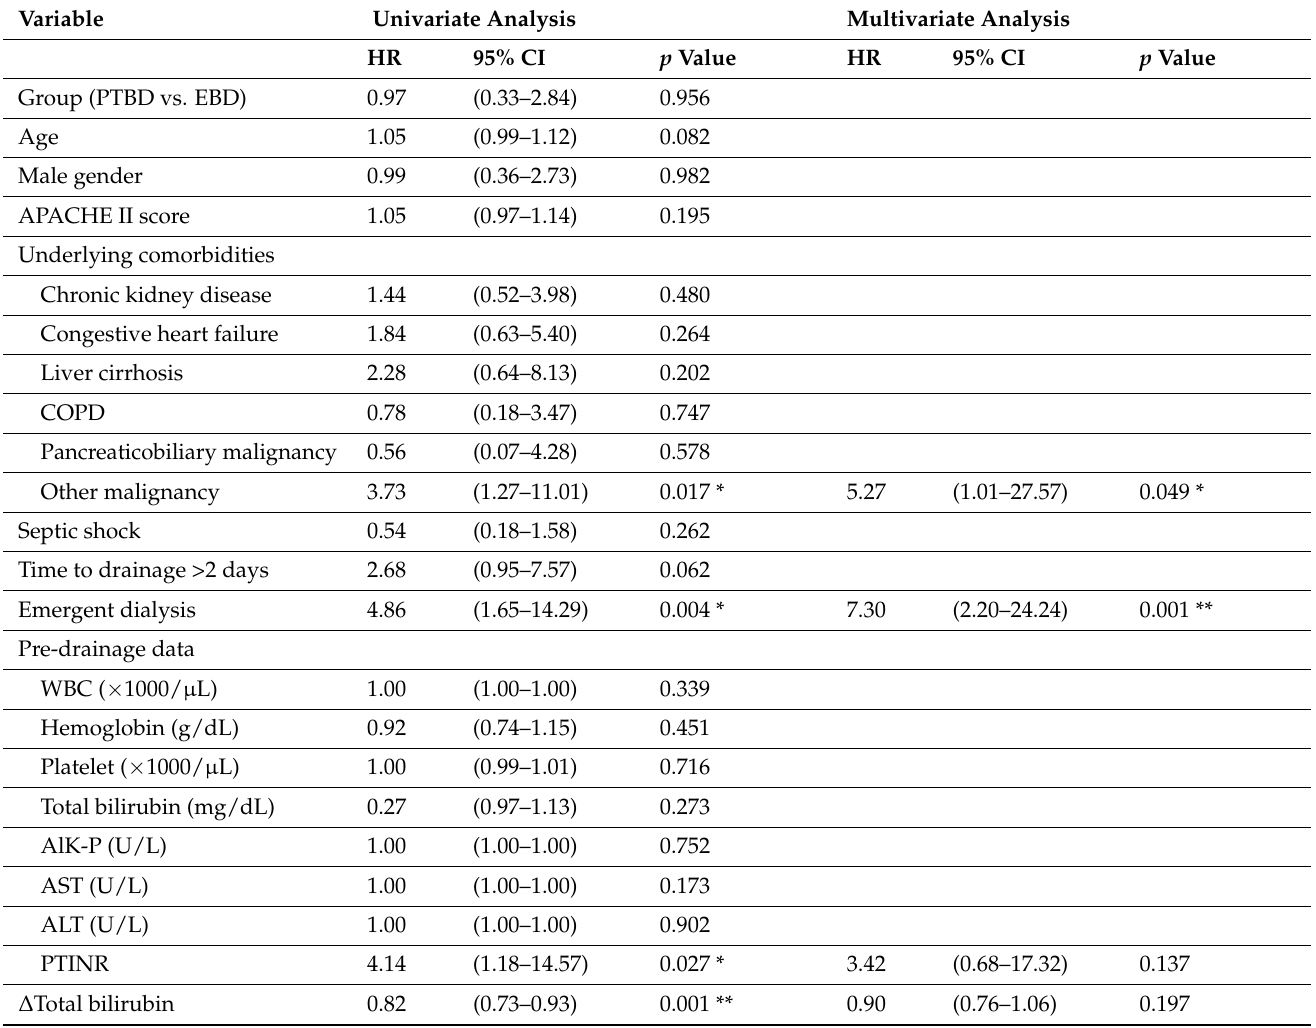
Table 4. Predictive factors associated with 30-day